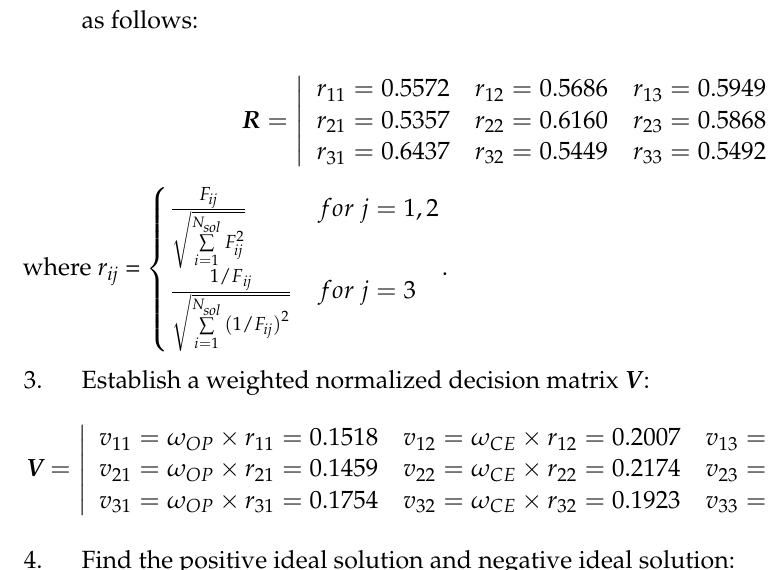
3. Establish a weighted normalized decision matrix V :